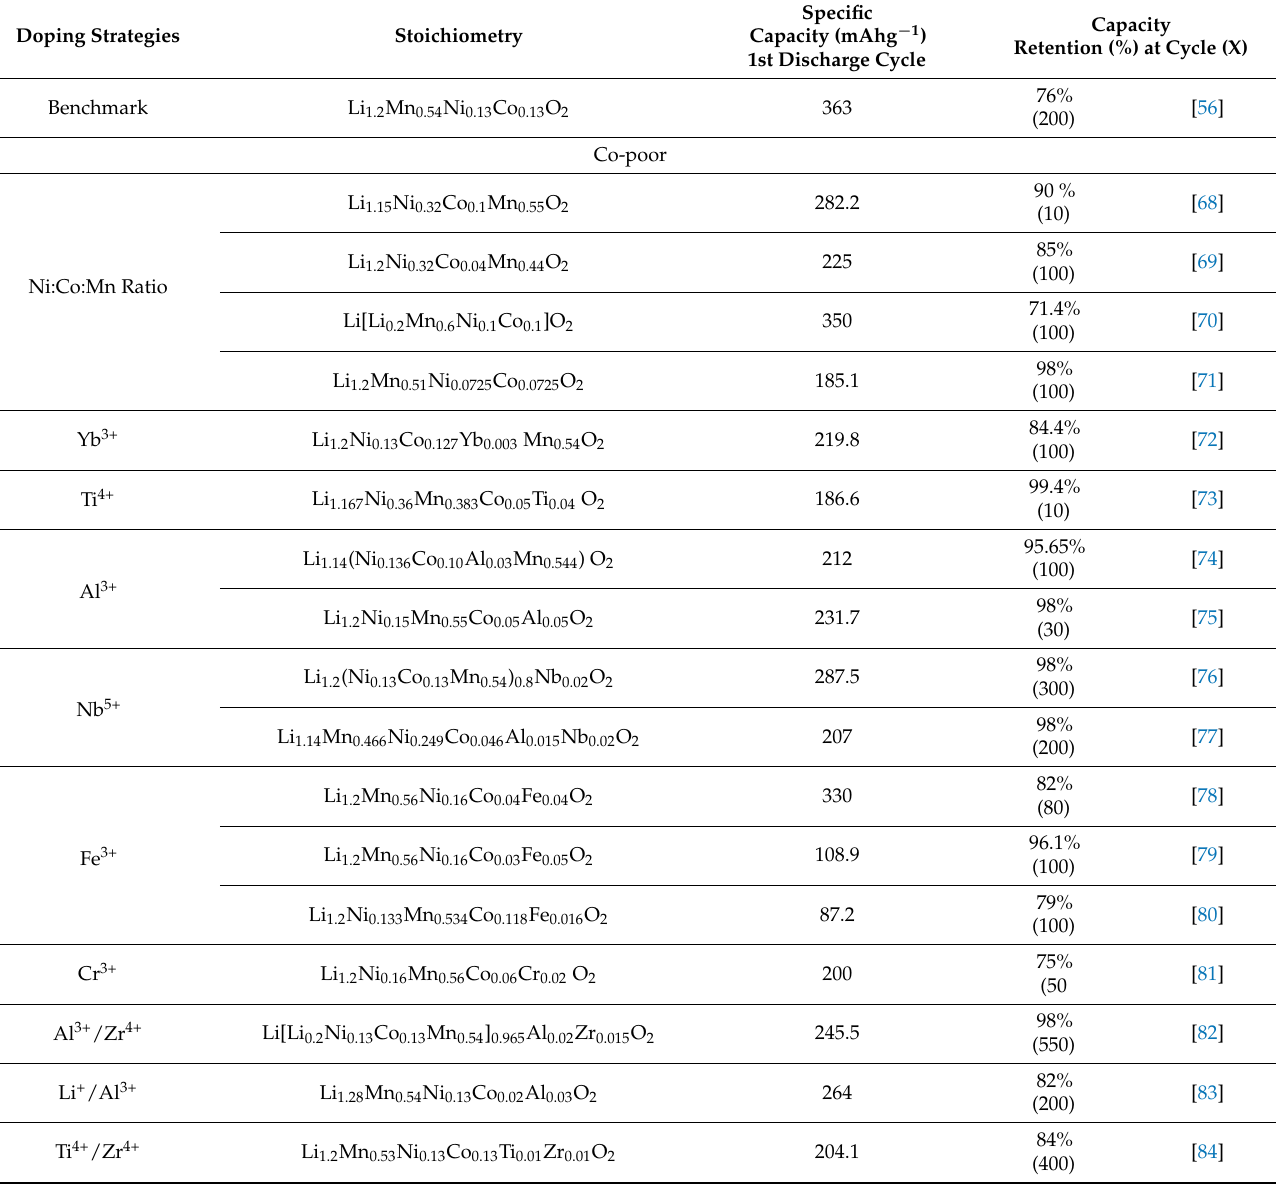
Table 1. Effect of Doping strategies on cathode